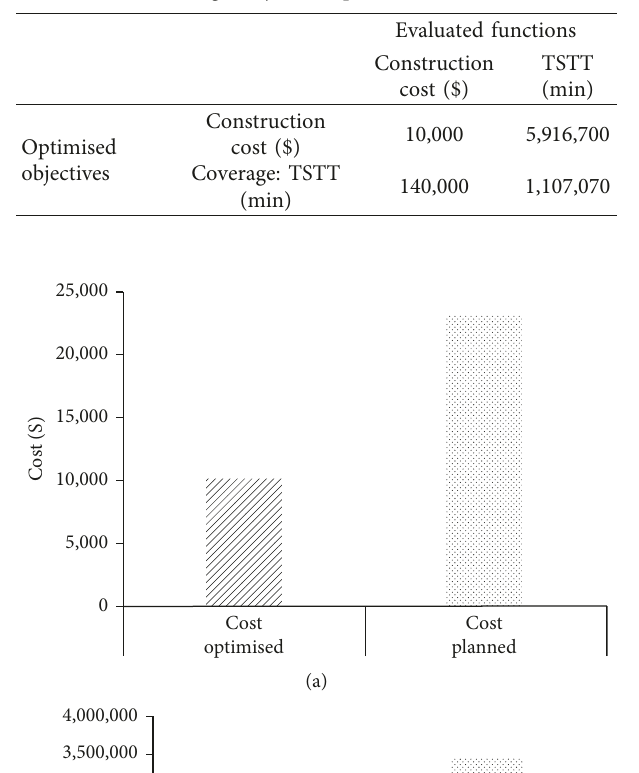
Table 5: Single objective optimisation of ELAP.